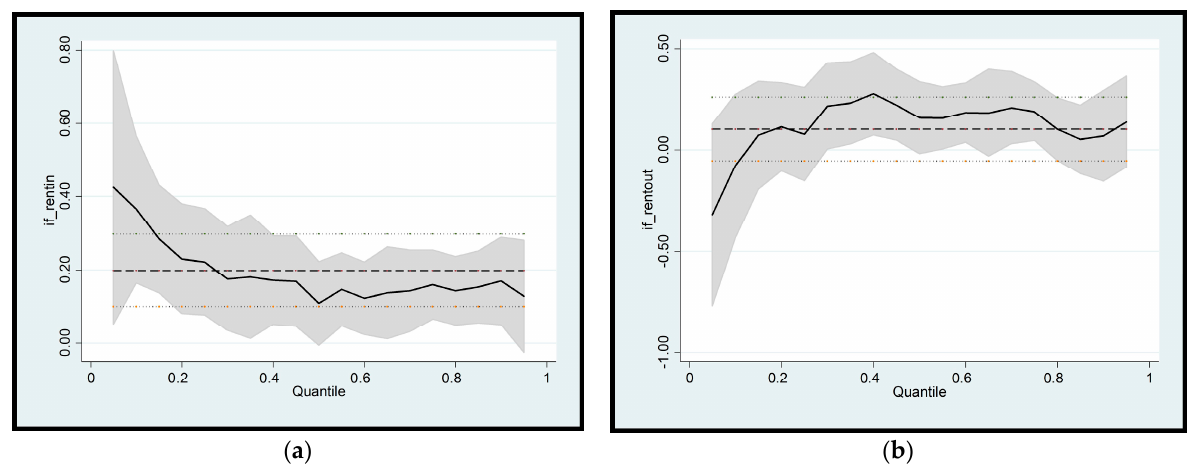
Figure 3. The effects of farmland renting in ( a ) and /renting out ( b ) on household total income across quantiles.